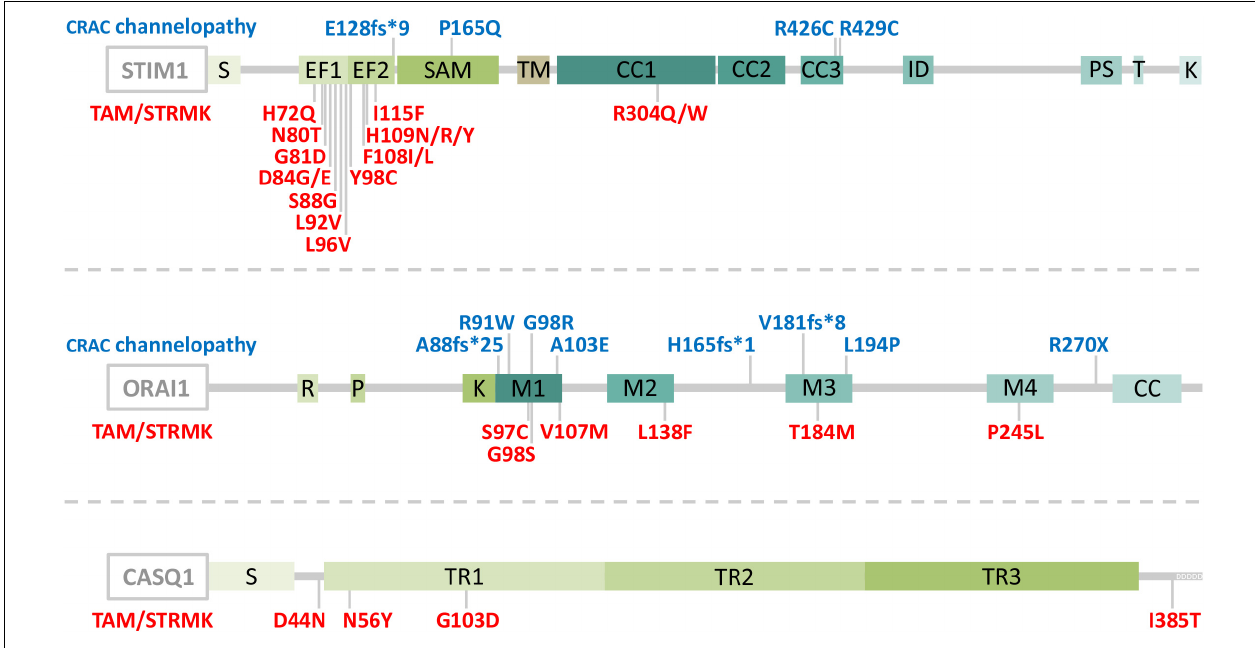
FIGURE 1 | Schematic representation of STIM1, ORAI1, and CASQ1 with position of the CRAC channelopathy and TAM/STRMK mutations. STIM1 is composed of a luminal part with a reticular signal sequence (S), Ca 2 + -binding EF-hands and a SAM domain, a transmembrane domain (TM), and a cytosolic part with coiled-coil (CC) domains 1–3, an inhibitory domain (ID), a proline/serine-rich region (PS), a TRIP domain (T), and a lysine-rich region (K). ORAI1 contains arginine (R), proline (P), and lysine (K)-rich regions, four transmembrane domains (M1-M4), and a coiled-coil domain (CC), and calsequestrin (CASQ1) contains a reticular signal sequence (S), three thioredoxin domains (TR1-3), and an N-terminal stretch of Ca 2 + -binding aspartic acid residues (DDDDD). CRAC channelopathy mutations are depicted in blue and TAM/STRMK mutations in red. Note that an additional STIM1 splice site mutation (c.970-1G > A) generates unstable transcripts and causes CRAC